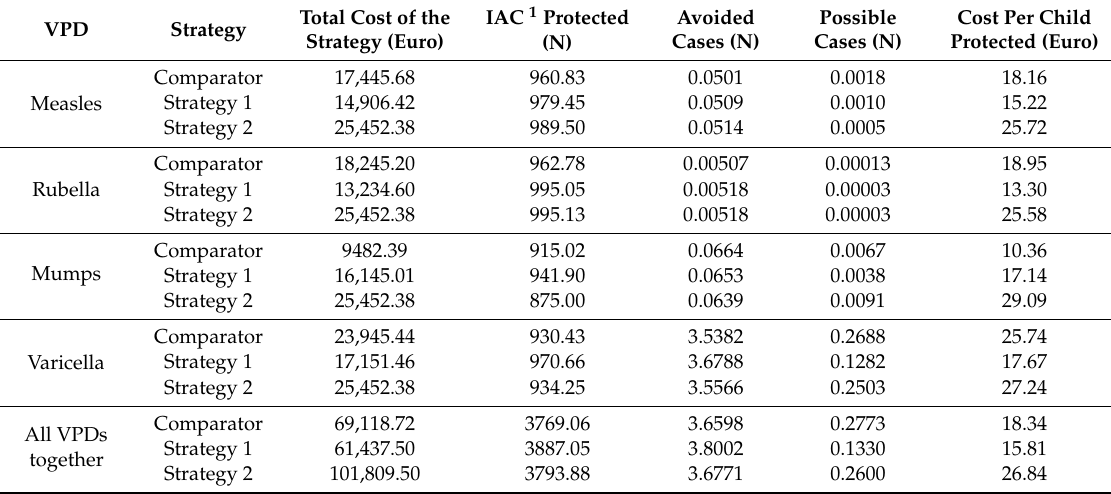
Table A1. Clinical and economic outcomes per 1000 internationally adopted children (IAC), by disease (CLIA serotesting).